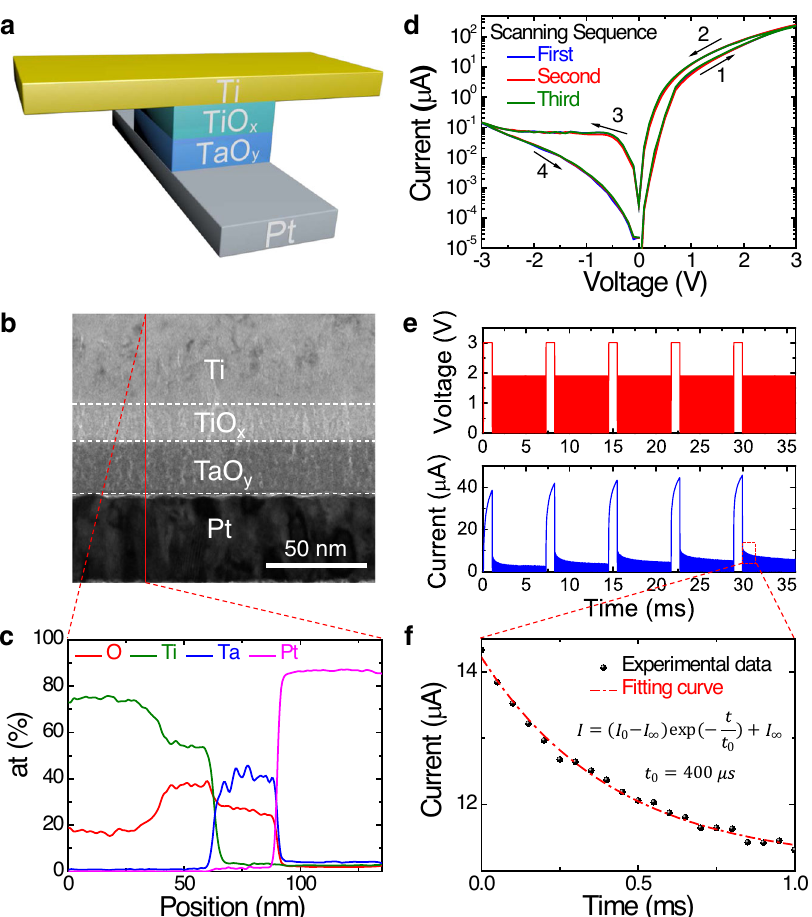
Fig. 1 Device characteristics of dynamic memristor. a Device structure and b cross-sectional transmission electron microscope (TEM) image of the fabricated dynamic memristor, consisting of a vertically stacked structure of Ti/TiO x /TaO y /Pt (50 nm/16 nm/30 nm/50 nm). c Corresponding elements distribution pro fi le from energy-dispersive spectroscopy. d Device I – V hysteresis curves. Three scans were repeated, and the arrows indicate the direction of the voltage scan. e The experiment exploring the dynamic characteristics of device. Here the input sequence is a periodic signal composed of a write voltage pulse (3.0 V, 1 ms) followed by several read voltage pulses (1.9 V, 10 μ s) in one period. The responding current is recorded for subsequent analysis. f The current decay with time follows a simple exponential relationship and the characteristic time t 0 obtained by fi tting is 400 μ